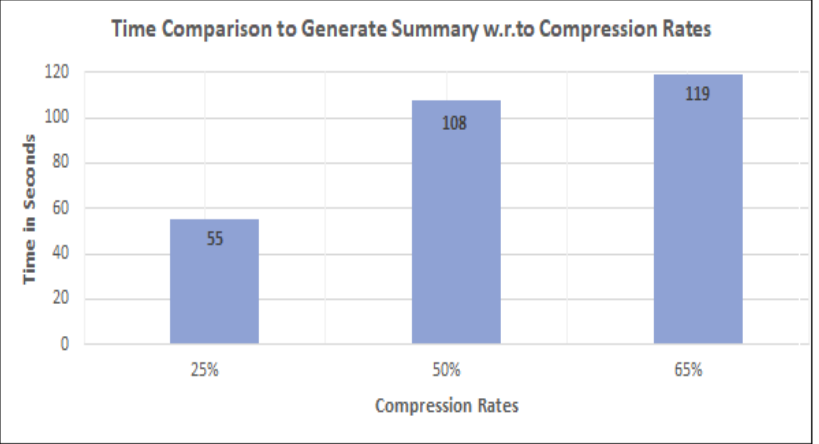
Figure 4. Time comparison to generate summary vs. comparison rates.